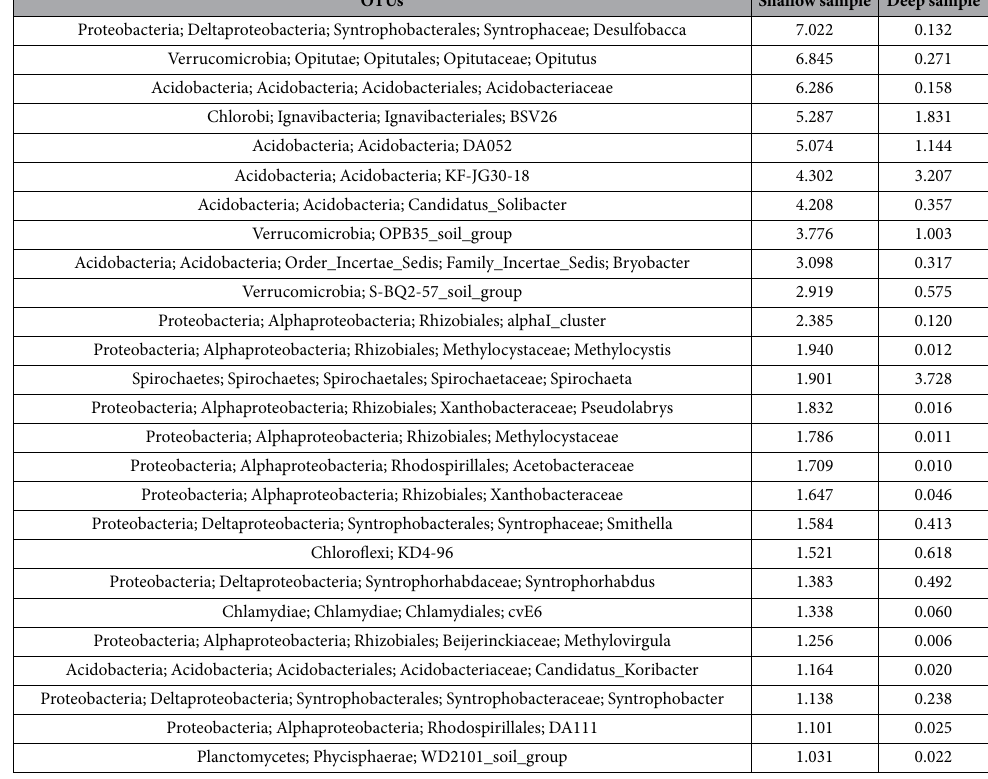
Table 3. Prokaryotic OTUs % at genus level (with cutoff > 1%) sorted by abundance in surface